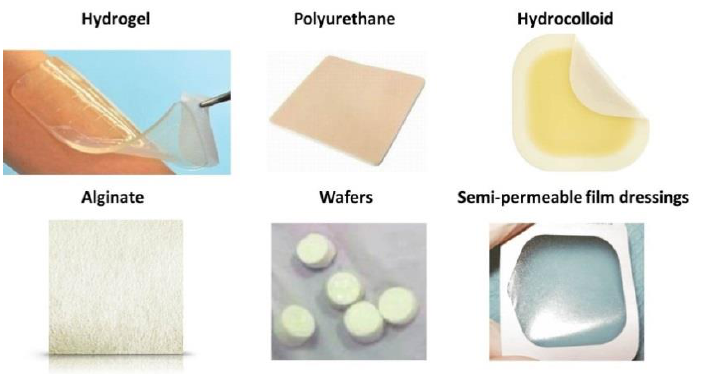
Figure 3. Types of wound treatment